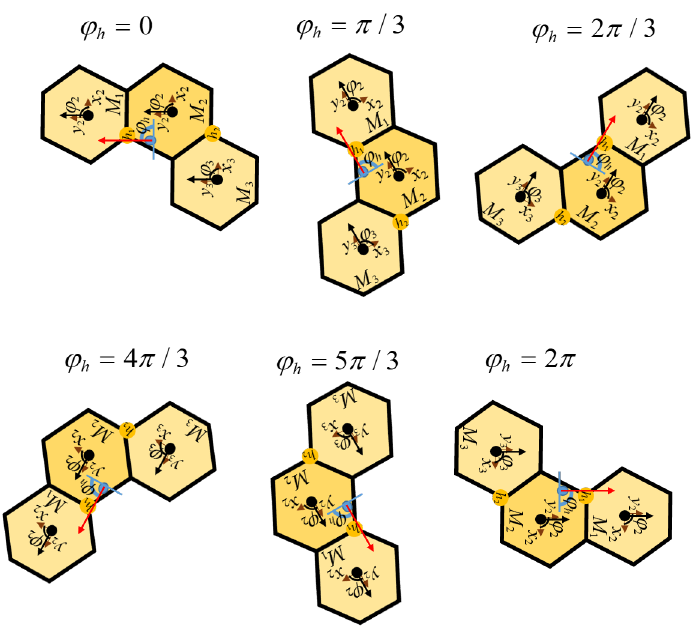
Figure 9. Module position inside the workspace corresponding with the heading of robot.